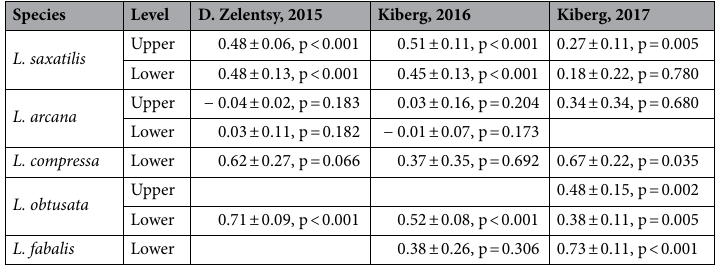
Table 4. Fidelity index (FI) of male Littorina snails grouped by species, intertidal level and year/site. FI measures prevalence of mating of males with conspecific females. It is computed as difference of observed and expected numbers of heterosexual conspecific copulations with males of a given species, divided by the total number of copulations with males of that species. Values of FI vary from − 1—avoidance, through 0—random mating, to 1—assortative mating. FI was not computed for L. saxatilis males with 1.5 rows of penial glands. Bootstrap means ± standard deviations are given; p —the two-tail probability of rejecting H 0 : FI = 0 in the test using bootstrap with 10 000 iterations.